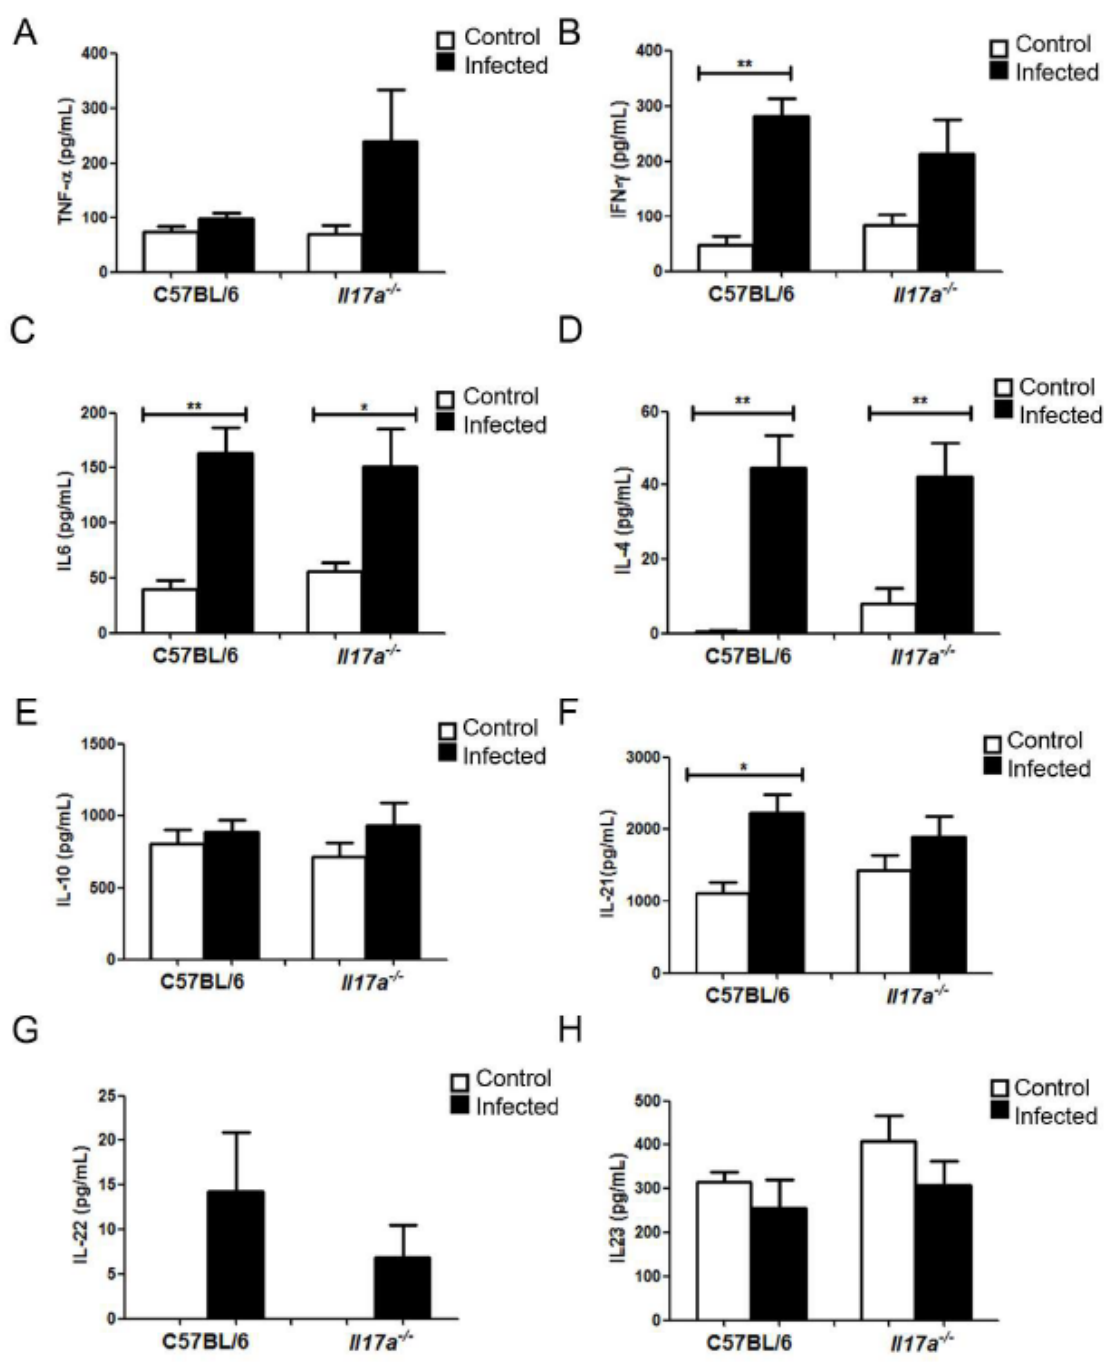
Figure 5. Cytokine concentration in lungs of C57BL/6J and Il17a -/- mice. C57BL/6J and Il17a -/- mice were infected with 10 6 yeast strain H99 per mouse (black bars) or treated with PBS (white bars). Concentration of TNF- α ( A ), IFN- γ ( B ), IL-6 ( C ), IL-4 ( D ), IL-10 ( E ), IL-12 ( F ), IL-22 ( G ), and IL-23 ( H ) was determined from lung extracts after 9 days of infection, as indicated in M&M. Figure represents mean and standard deviation of five different mice. Asterisks indicate significant difference between control and infected mice.